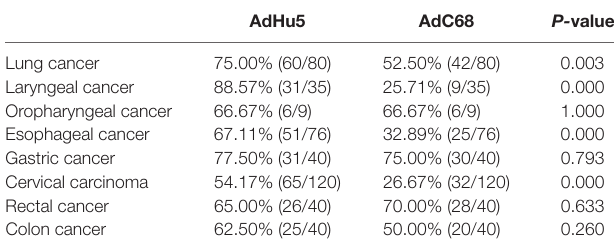
Table 3 | Seroprevalence of AdHu5 and AdC68 neutralizing antibody in patients with different types of cancer. adhu5 adc68 P- value Lung cancer